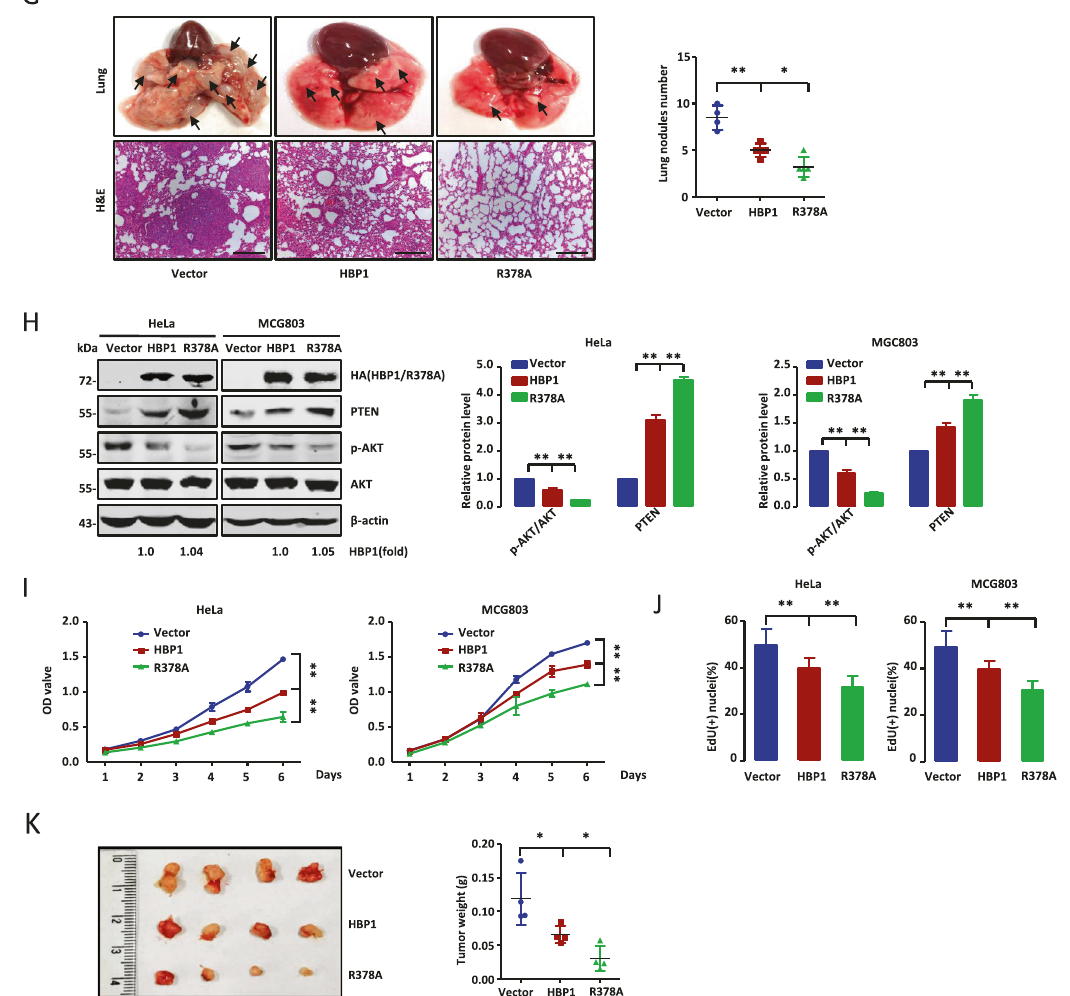
Fig. 3 HBP1 methylation alleviates HBP1-mediated suppression of metastasis and growth of tumor cells. A – D PRMT1-mediated HBP1 methylation participates in PRMT1-induced metastasis in tumor cells. A The protein levels of metastasis-related markers were detected by western blotting in HeLa cells transfected with PRMT1 with or without HBP1. B The protein levels of metastasis-related markers were detected by western blotting in HeLa cells transfected with shPRMT1 with or without shHBP1. C The migratory and invasive potential of HeLa cells transfected with PRMT1 with or without HBP1 were measured by Transwell assay ( n = 4, one-way ANOVA). Scale bar, 200 µm. D The migratory and invasive potential of HeLa cells transfected with shPRMT1 with or without shHBP1 were measured by Transwell assay ( n = 4, one-way ANOVA). Scale bar, 200 µm. E , G HBP1 methylation alleviates HBP1-mediated suppression of metastasis of tumor cells. E HeLa and MGC803 cells were transfected with empty vector, HBP1 or R378A and the protein levels of metastasis-related markers were veri fi ed by western blotting. F The migratory and invasive potential of HeLa and MGC803 cells transfected with empty vector, HBP1, or R378A were measured by Transwell assay ( n = 4, one-way ANOVA). Scale bar, 200 µm. G The empty vector, HBP1 and R378A stably transfected HeLa cells were injected into nude mice via the tail vein. Visible lung tumors were quantitatively analyzed (top and right panels). Representative images and hematoxylin and eosin (H&E) staining of metastatic lung tumors are shown (bottom panels) ( n = 5, one-way ANOVA). Scale bar, 200 µm. H – K HBP1 methylation alleviates its inhibition of tumor growth. H HeLa and MGC803 cells were stably transfected with empty vector, HBP1 or R378A and the levels of PTEN, p-AKT and AKT were measured by western blotting. I , J Proliferation rates of the cells above were measured by MTT ( n = 3, one-way ANOVA) ( I ) and EdU ( J ) ( n = 7, one-way ANOVA) assays. K HeLa cells stably transfected with empty vector, HBP1 or R378A were subcutaneously injected into nude mice. Tumor volume and weight were quantitatively analyzed after 4 weeks ( n = 4, one-way ANOVA). Date were the mean ± SD. * p < 0.05, ** p <